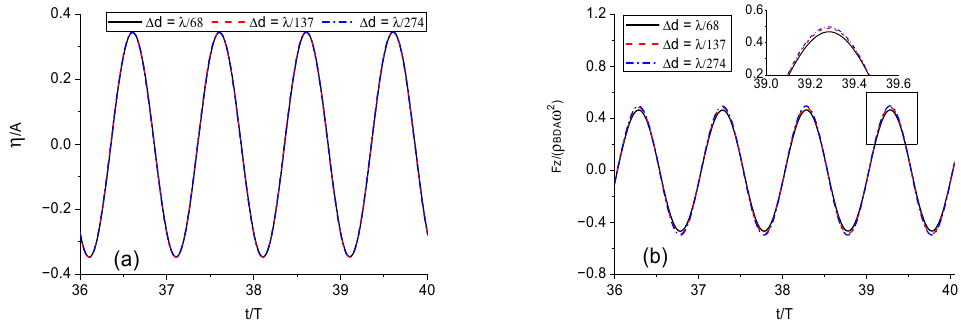
Figure 4. Convergence study with element size.: ( a ) wave runup on the right side of the body; ( b ) vertical force on the body.